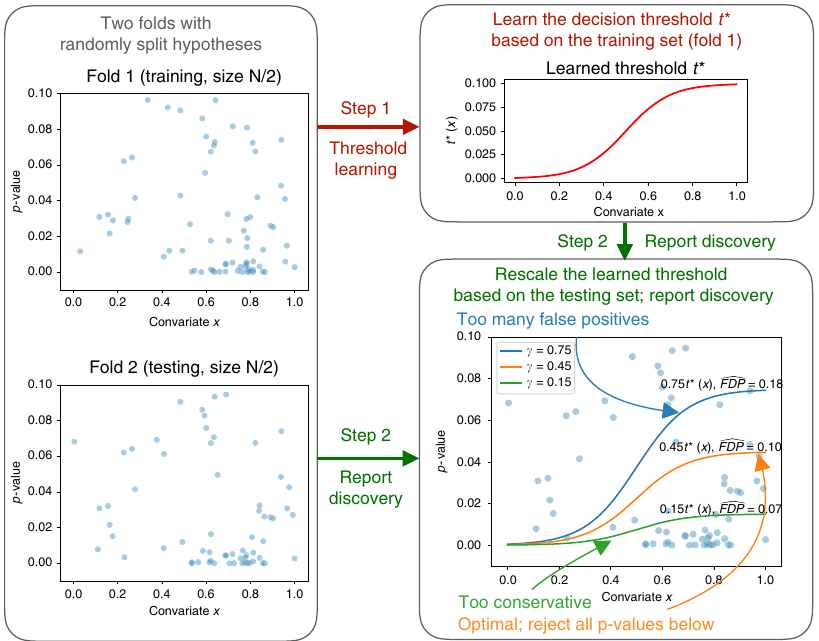
Fig. 5 Schematic of the AdaFDR learning and testing process. Fold 1 is the training set and fold 2 is the testing set (left panel). In step 1, a decision threshold t * ( x ) is learned on the training set via solving the optimization problem (1) (upper-right panel). In step 2, as shown in the bottom-right panel, this learned threshold t * ( x ) is fi rst rescaled by a factor γ * , de fi ned as the largest number whose corresponding mirror-estimated FDP on the testing set is less than α (orange). Then all p -values on the testing set below the rescaled threshold are rejected. Here the nominal FDP is α =